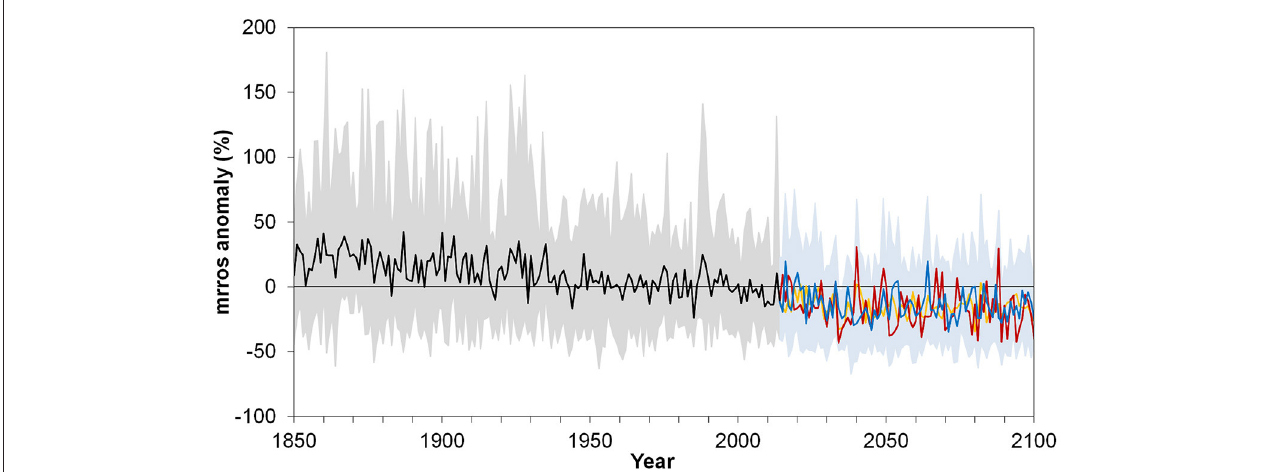
FIGURE 8 | Mean annual variations in surface runoff (mrros) over the Andes region, considering historical (1850–2014) and future (2015–2100) runs of the IPSL-CM6A-LR model, expressed as the percentage of change relative to the 1981–2010 baseline period. The black line represents the ensemble mean for the historical runs, the shading in gray indicates the 5 and 95% quantiles across the historical model runs. The blue, orange, and red lines show the ensemble mean of the future surface runoff projections considering the SSP1-1.9, SSP1-2.6, and SSP4-3.4 scenarios, respectively. The light-blue shading indicates the 5 and 95% quantiles across the future